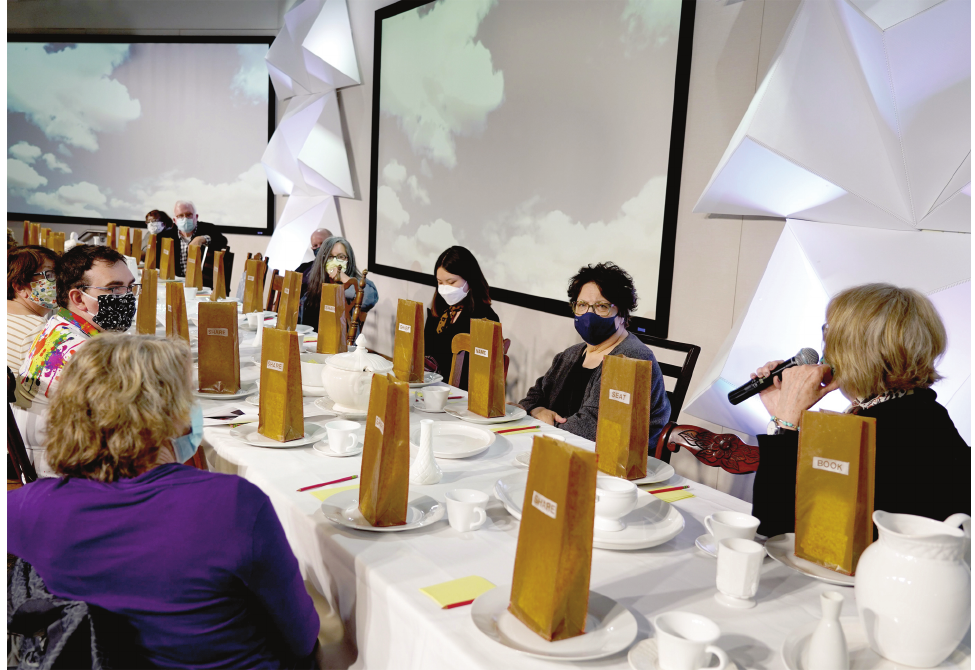
Figure 3. Share Table, 2021, photographer, Susan